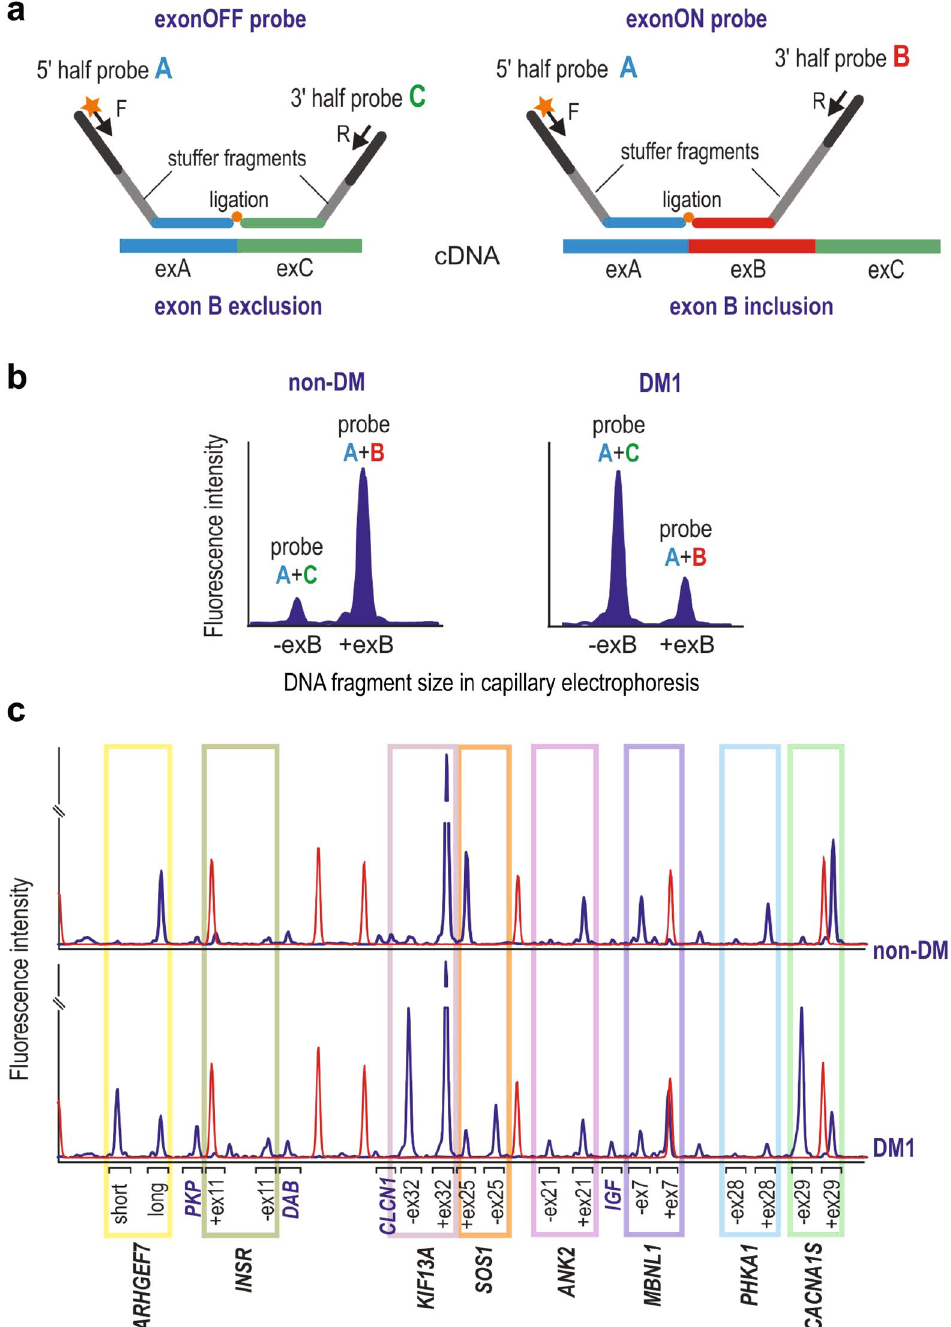
Figure 2. MLPA Assays Designed. ( a ) Schematic representation of the ex-OFF probe (left panel) and the ex-ON probe (right panel) specifically hybridized to the cDNA of a transcript, respectively, without and with the alternative exon B. Exons A and C are constitutive exons flanking the alternative exon B. Each of the exon-specific probes is composed of a 5 ′ half-probe and a 3 ′ half-probe (5 ′ half-probe is shared by both ex-OFF and ex-ON probes). Each half-probe is composed of a target-specific sequence (indicated by a color corresponding to targeted exon), stuffer sequence (gray), and sequence specific to either F (labeled) or R universal primers. Note that stuffer sequence in 3 ′ half-probe is different in size in the ex-OFF and ex-ON probes allowing differentiating the signal of probes in capillary electrophoresis. ( b ) Comparison of ssMLPA signals (electropherogram peaks) of the hypothetical exon-specific pair of probes (shown in panel a) in non-DM and DM1 samples (note, different ratio of signals of ex-ON and ex-OFF probes in compared samples). The ratio of signals from both peaks was used to calculate the PSI value for each sample. ( c ) Representative ssMLPA results (electropherograms) of non-DM and DM1 samples. Blue peaks represent signals of MLPA probes used for indicated genes. The color rectangles indicate the pairs of exon-specific probes. The signals outside the rectangles represent control probes. Red peaks denote GS Liz600 DNA size